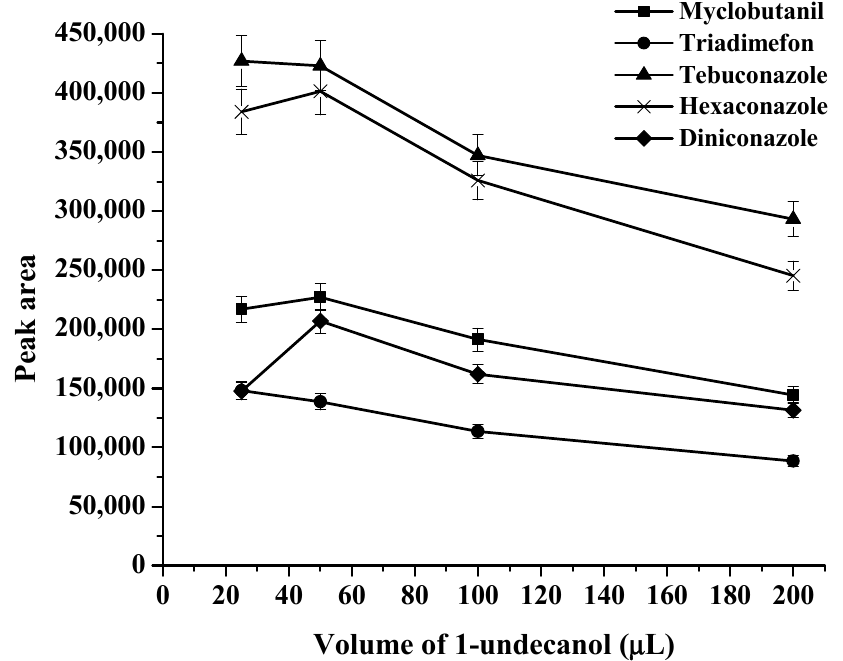
Figure 4. Effect of volume of 1-undecanol on extraction efficiency.